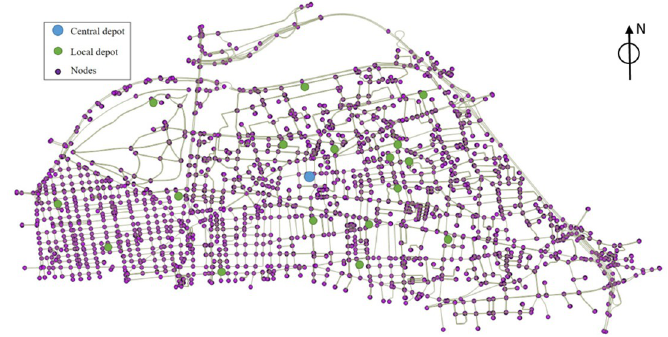
Fig 5. Central depot and local depots in a part of Lyon